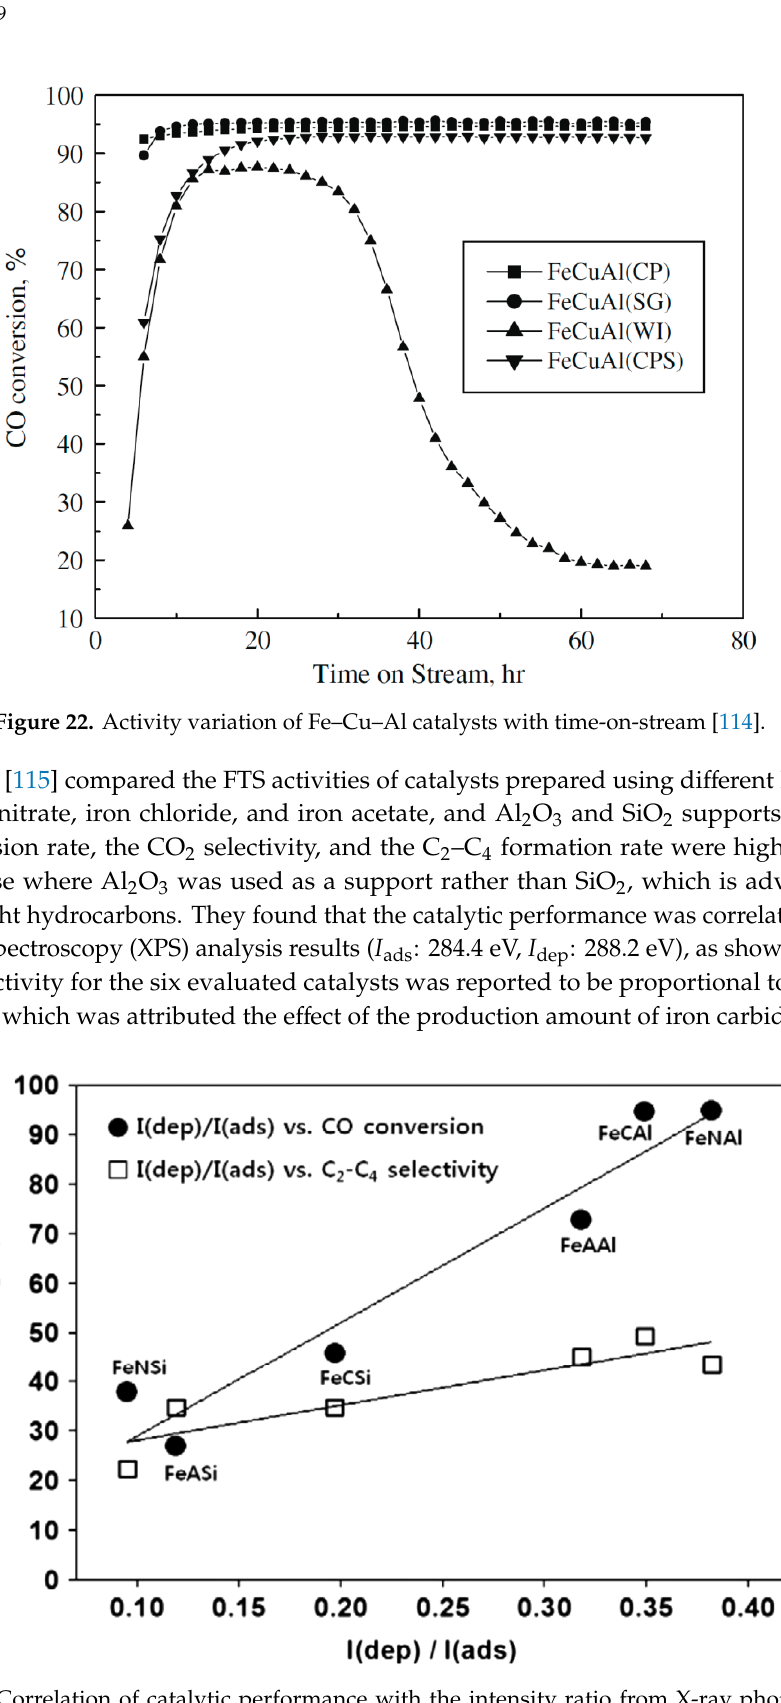
Figure 23. Correlation of catalytic performance with the intensity ratio from X-ray photoelectron spectroscopy (XPS) results. Reprinted with permission from [115]. Copyright (2013) Elsevier Science